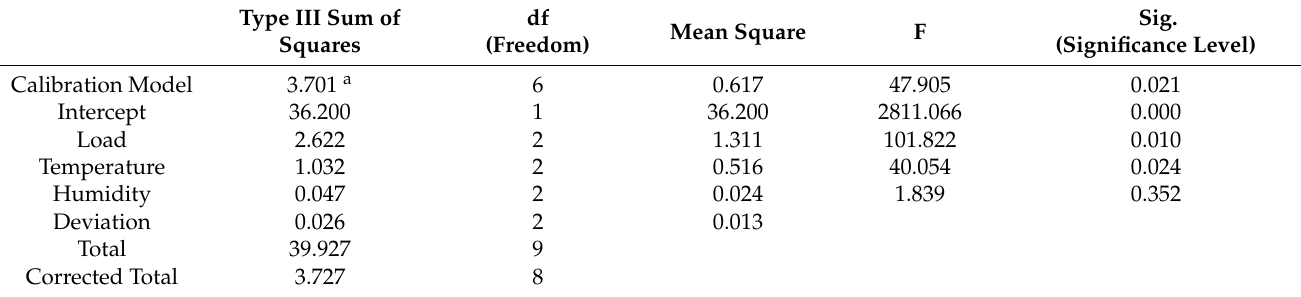
Table 4. Test of the intersubjectivity